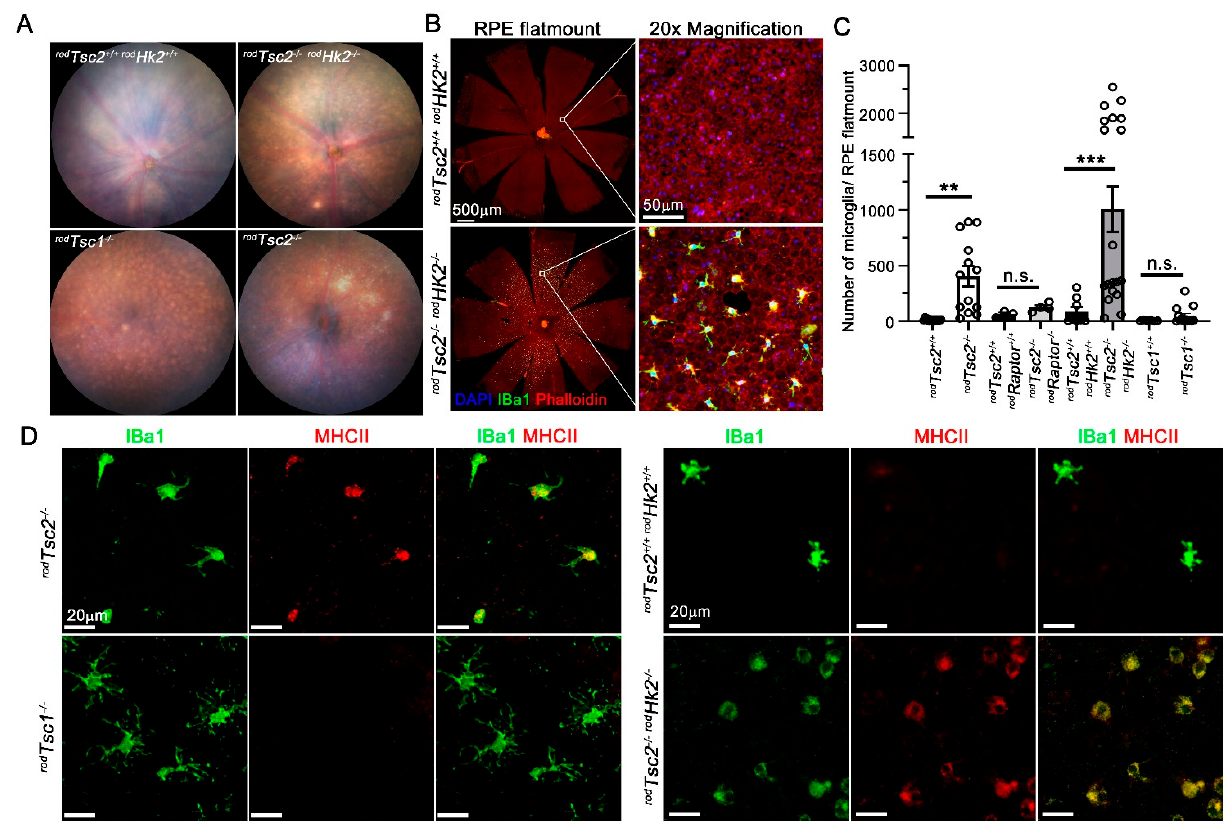
Figure 5. Microglia migration and activation seen in the subretinal space of 12 M old mice. ( A ) Representative fundus images of genotype indicated. For the Cre – negative controls, only the rod Tsc2 +/+ rod Hk2 +/+ mice are shown. Quantification of all Cre – controls is shown in ( C ). ( B ) Representative RPE flat mounts and zoomed in images of two of the genotypes shown in ( A ), namely rod Tsc2 − / − rod Hk2 − / − mice and their Cre – controls, showing a large number of IBa1 positive (green) cells in rod Tsc2 − / − rod Hk2 − / − mice. ( C ) Quantification of total number of IBa1+ cells on RPE flat mounts of genotypes indicated at 12 M. Each bar shows the average number of IBa1+ cells accumulated on RPE flat mounts ±S.E.M. (Each dot shows cell count of a single RPE flat mount. Number of flat mounts per genotype varies between 4 and 20. Lower number was used for genotypes where microglia were rarely seen by fundus. ** p < 0.01; *** p < 0.001.) ( D ) Representative images of the two different types of IBa1+ (green) cells seen on RPE flat mounts that differ by their amount of MHCII signal (red). In rod Tsc2 − / − mice and rod Tsc2 − / − rod Hk2 − / − mice, many IBa1+ cells have higher levels of MHCII expression. In rod Tsc1 − / − mice, the IBa1-positive cells look more ramified with very low levels of MHCII (scale bar = 20 µm).